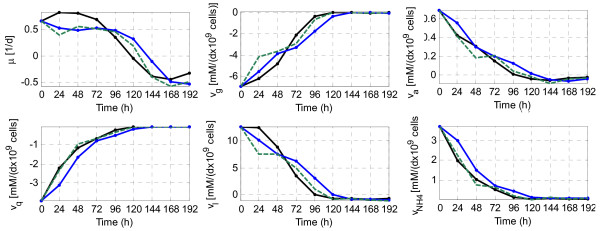
Extracellular fluxes and growth rate calculated from the measured concentrations. μ is the biomass growth rate, vg, the flux of glucose, vQ the flux of glutamine, vL the flux of lactate, vA the flux of alanine and vNH4 the flux of ammonia. Fluxes are calculated with the middle point Euler approximation (black solid line) and the backward Euler approximation (green dotted line). In addition, fluxes calculated with the backward Euler approximation and filtered with a standard moving average of order 2 are also depicted (blue solid line).